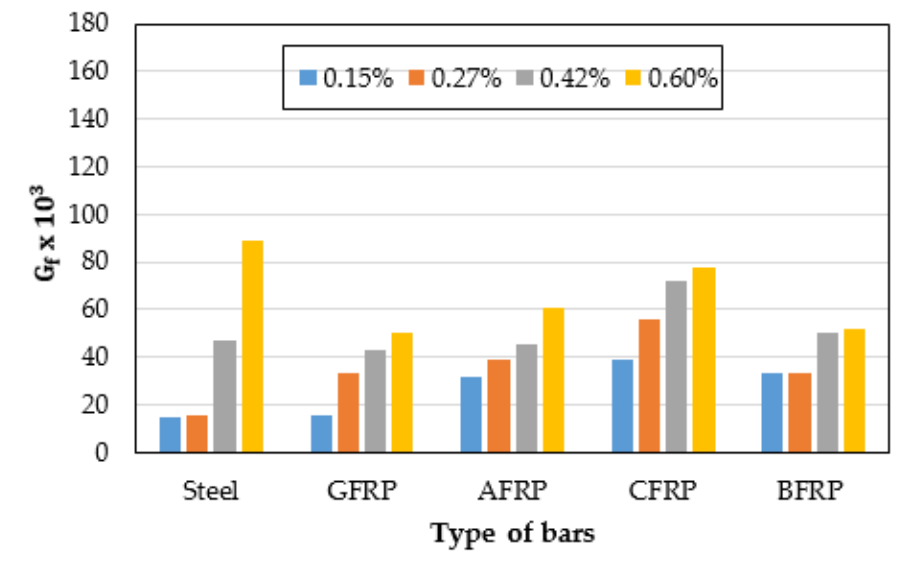
Figure 12. Fracture energy vs. Type of bars.